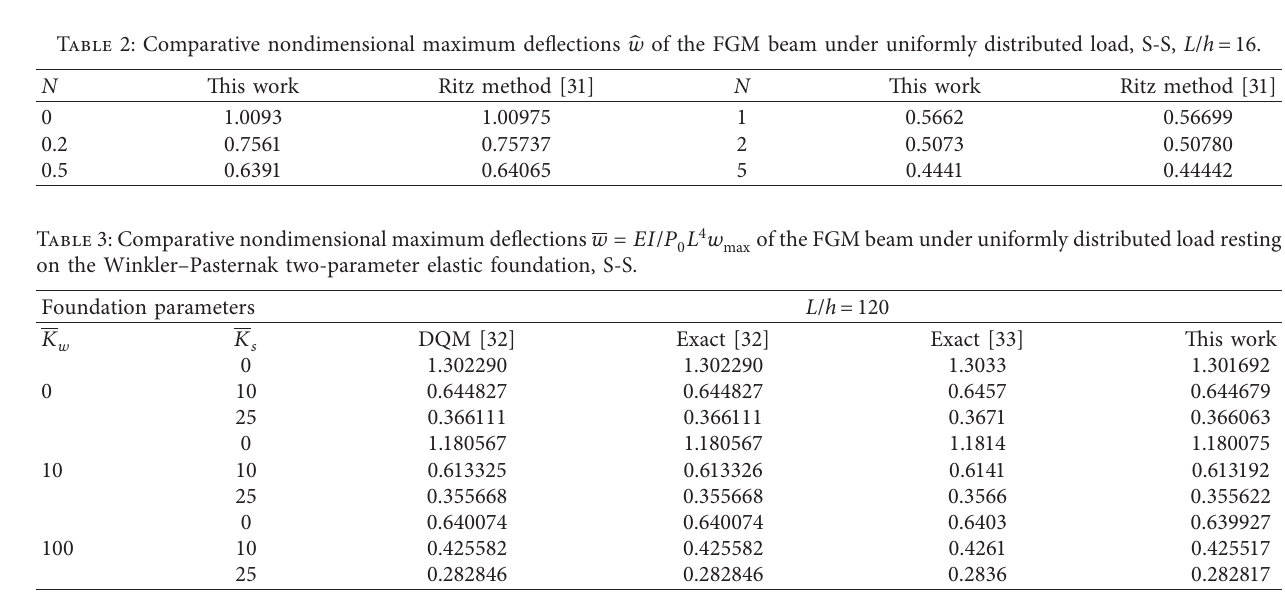
Table 2: Comparative nondimensional maximum deflections 􏽢 w of the FGM beam under uniformly distributed load, S-S, L / h � 16.